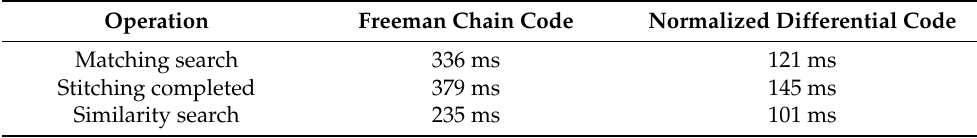
Table 6. Comparison of the average time to complete a stitching matching.